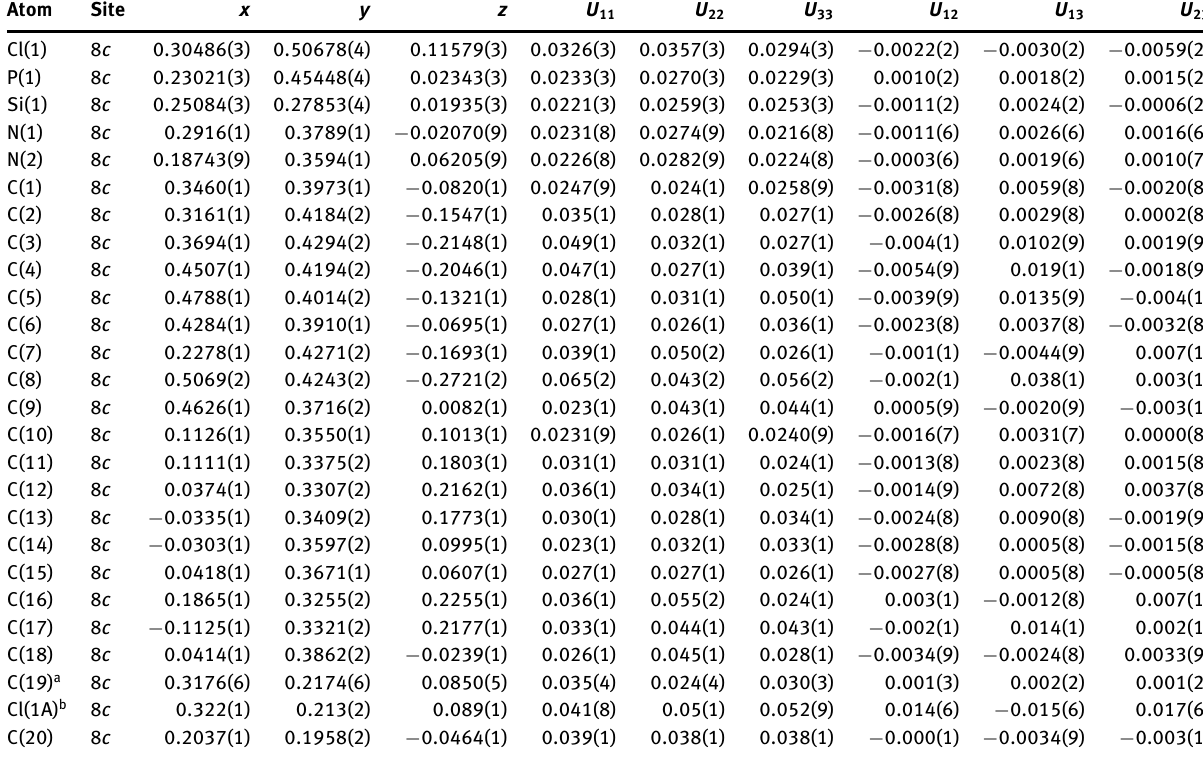
Table 3: Fractional atomic coordinates and atomic displacement parameters (Å 2